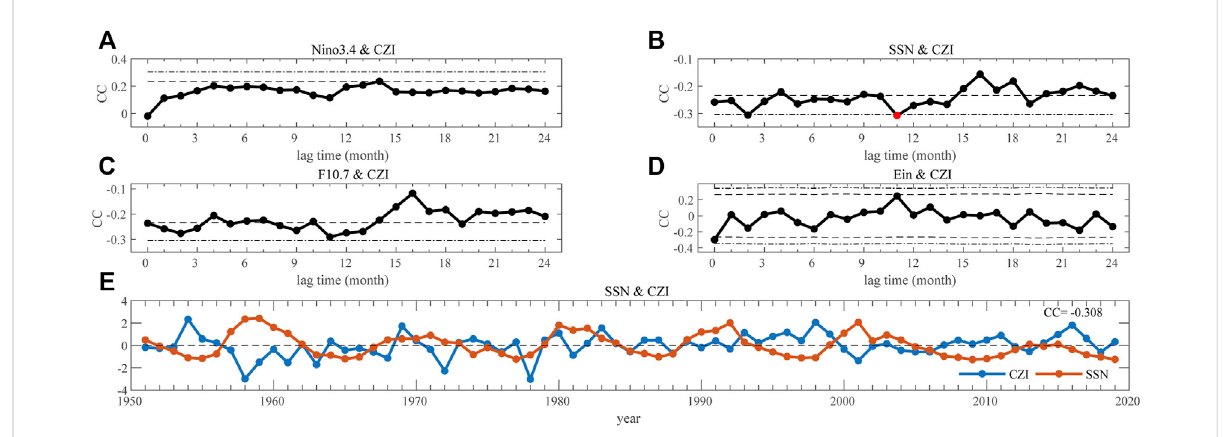
FIGURE 2 Pearson correlation coef fi cients ( CC ) between precipitation in June-July and other indices by considering the time-lagged effect. (A) Niño3.4 (B) SSN, (C) F10.7, and (D) E in . The black dashed (dot-dashed) lines denote the 95% (99%) con fi dence level. The red dots denote the